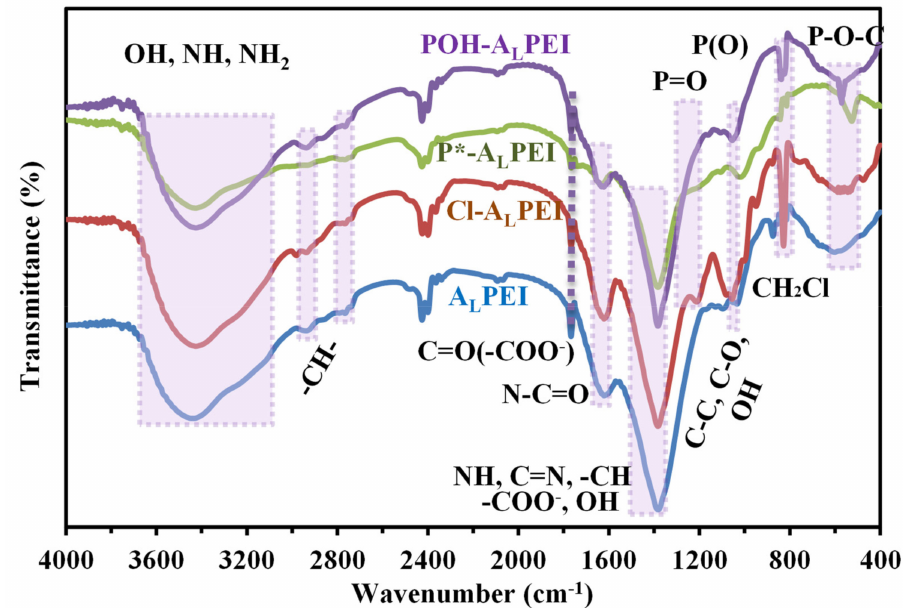
Figure 2. FTIR spectra of A L PEI, intermediary products (epichlorohydrine-activated A L PEI, Cl- A L PEI and phosphorylated A L PEI beads, P*-A L PEI) and sorbent (de-esterified phosphorylated beads, POH-A L